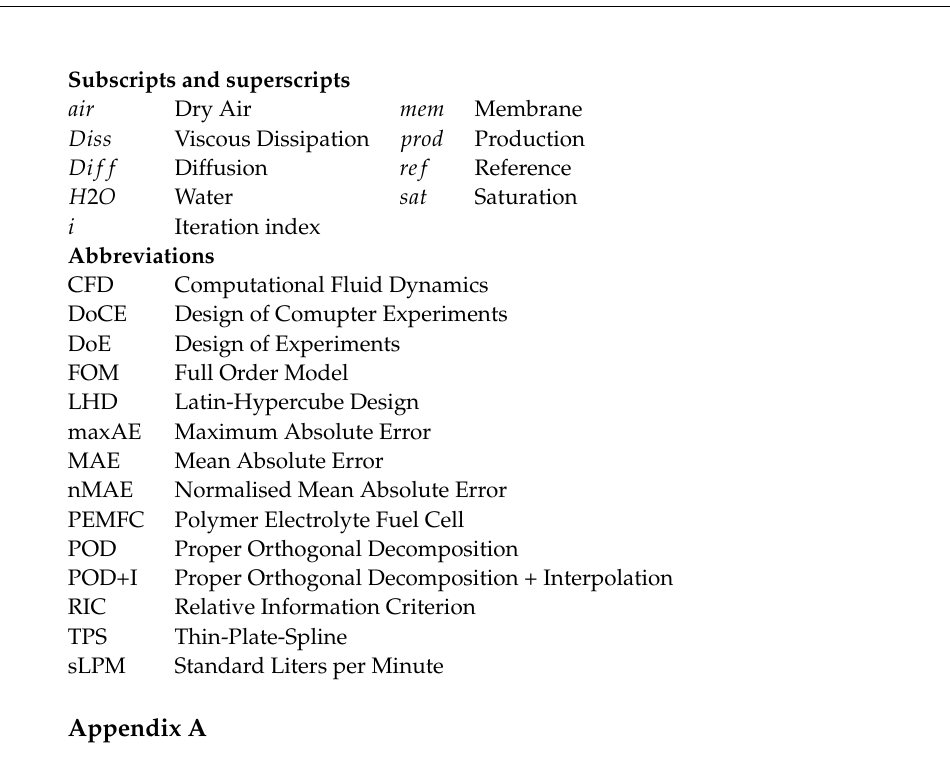
Table A1. Comparison of measured and simulated results, upscaled to the full size humidifier. The points used for the calibration of the diffusion coefficient of the membrane are marked with a